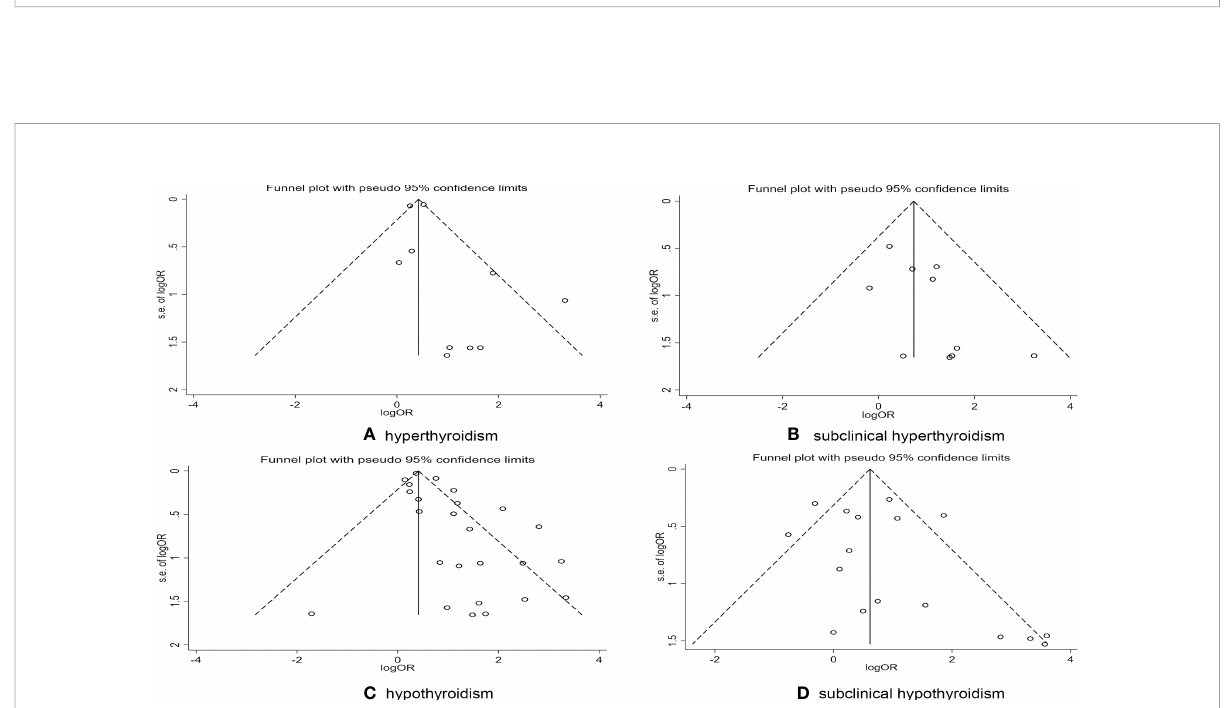
FIGURE 4 Publications bias detected by funnel plot on the risk of thyroid dysfunction in RA patients. (A) Publications bias detected by funnel plot on the risk of hyperthyroidism in RA patients. (B) Publications bias detected by funnel plot on the risk of subclinical hyperthyroidism in RA patients. (C) Publications bias detected by funnel plot on the risk of hypothyroidism in RA patients. (D) Publications bias detected by funnel plot on the risk of subclinical hypothyroidism in RA patients.